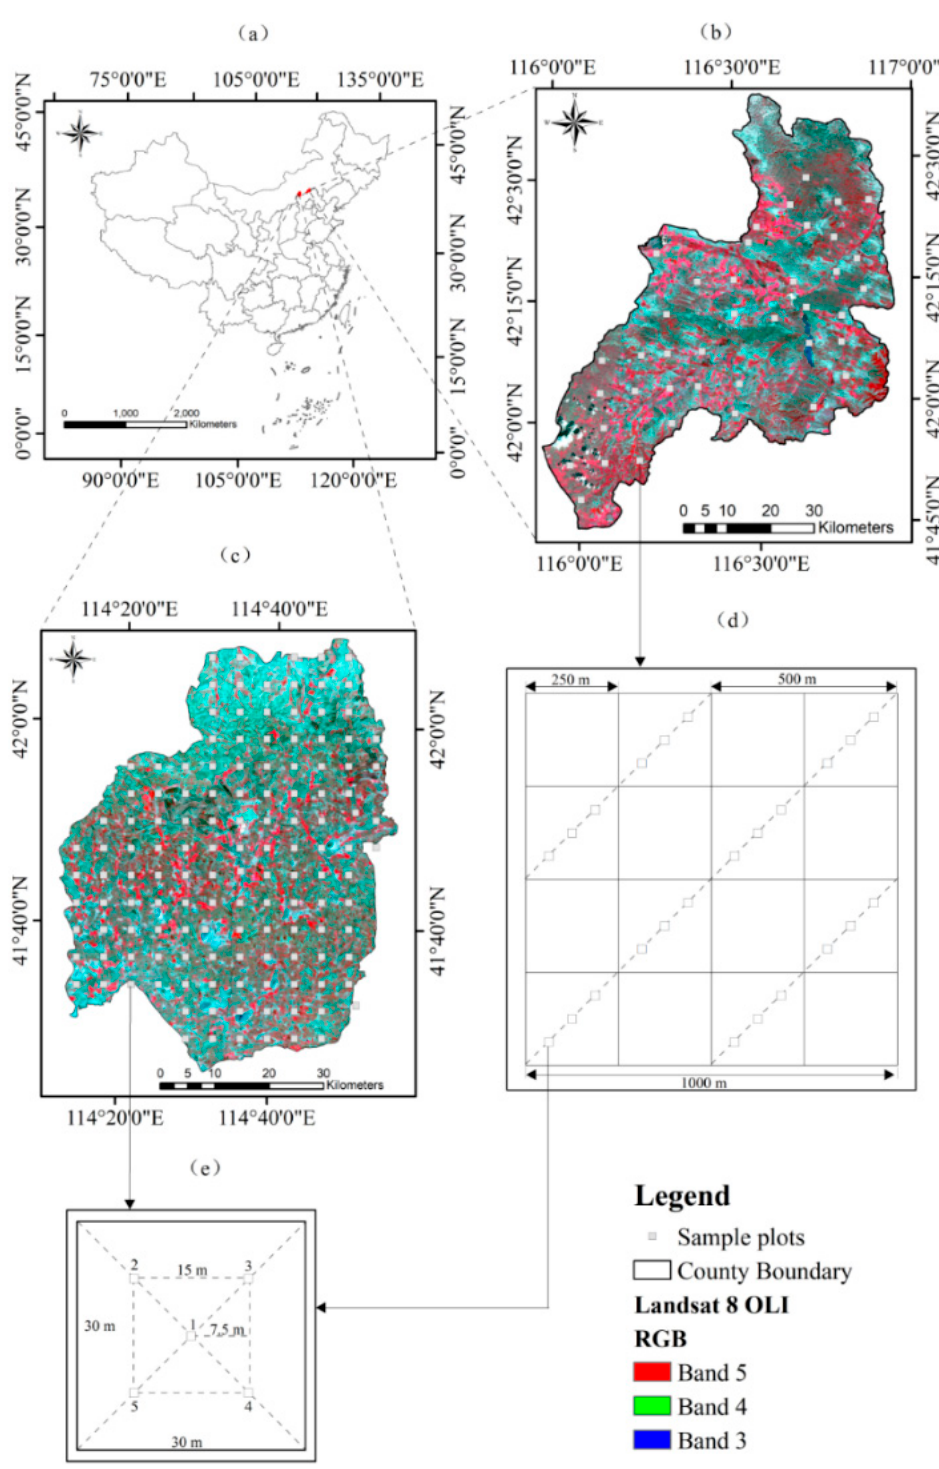
Figure 2. ( a ) Locations of two study areas (Duolun and Kangbao) in China; ( b ) Duolun County shown using a Landsat operational land imager (OLI) composition image consisting of band 5 (red), band 4 (green), and band 3 (blue) with the spatial distribution of 1000 m × 1000 m sampled blocks (grey); ( c ) Kangbao County shown using a similar composition image with the spatial distribution of systematically sampled plots of 30 m × 30 m; ( d ) the spatial distribution of nested 250 m × 250 m and 500 m × 500 m sub-blocks, and 30 m × 30 m sample plots in Duolun; and ( e ) the allocation of five 1 m × 1 m sub-plots within each 30 m × 30 m sample plot for both Duolun and Kangbao.